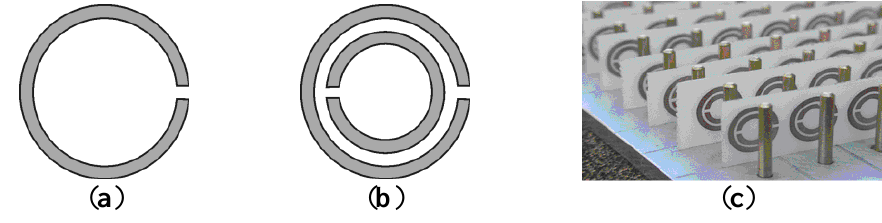
Figure 2. ( a ) λ /2 ring resonator. ( b ) Split ring resonator (SRR). ( c ) First bulk SRR-based reported structure exhibiting backward wave propagation in a certain frequency